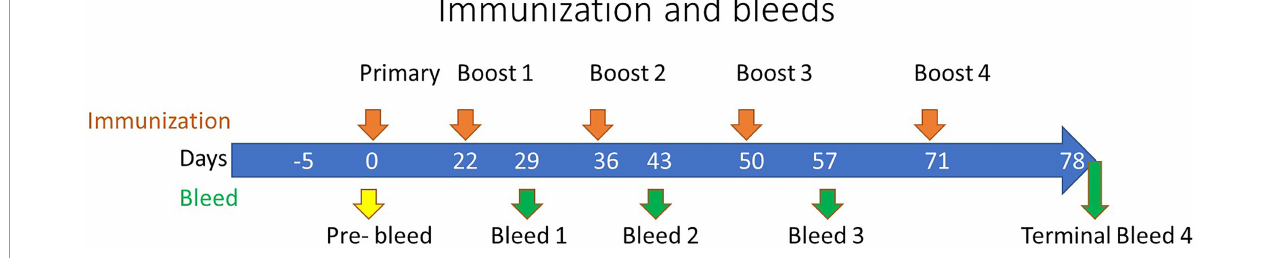
FIGURE 1 | Rabbit Immunization Schedule. The immunization of rabbits is depicted along the top of the timeline by orange arrows at 0, 22, 36, 50, and 71 days representing the primary and subsequent boosts, respectively. The pre-immunization bleed (yellow arrow) was conducted at day zero with subsequent test bleeds performed along the timeline as denoted by the green arrows at 29, 43, and 57 days, with a terminal bleed at day